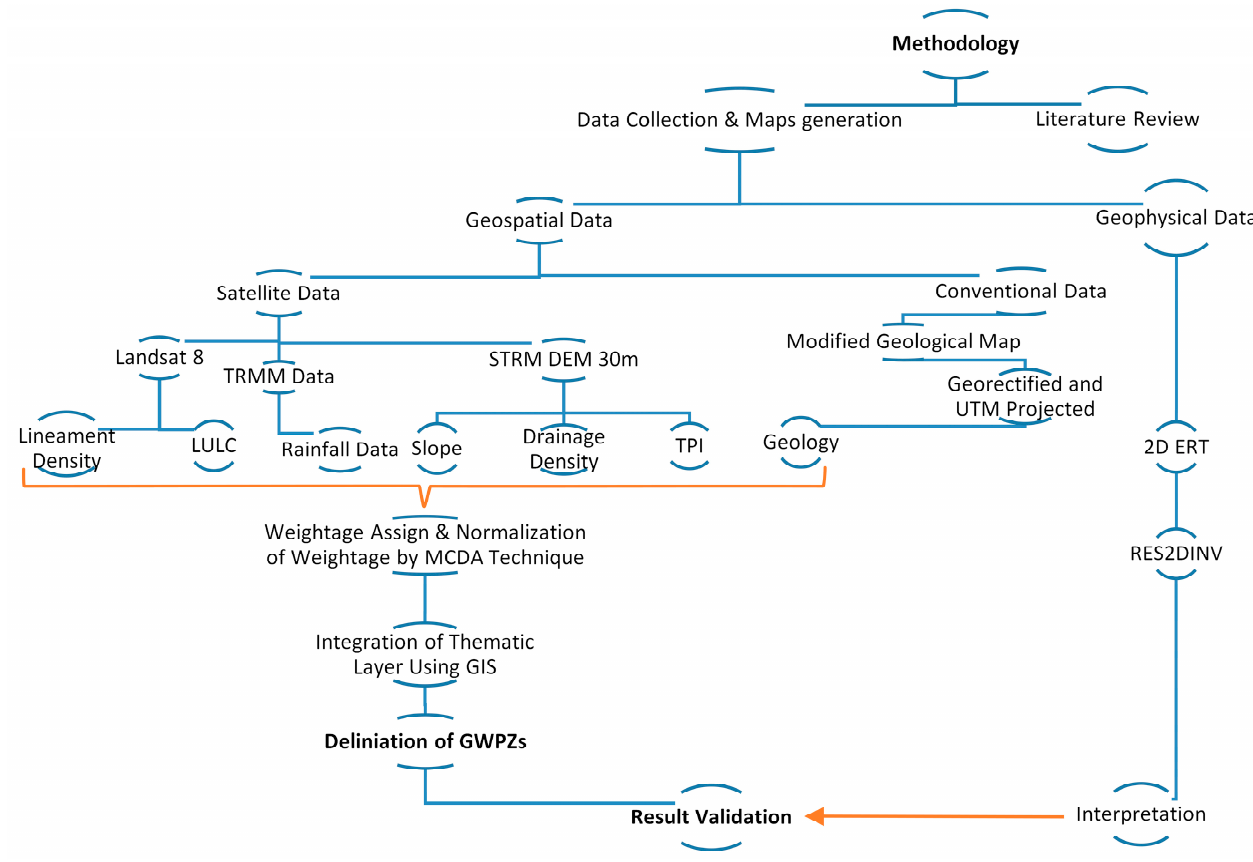
Figure 4. Flowchart displaying methodology adapted for delineating the GWPZs.